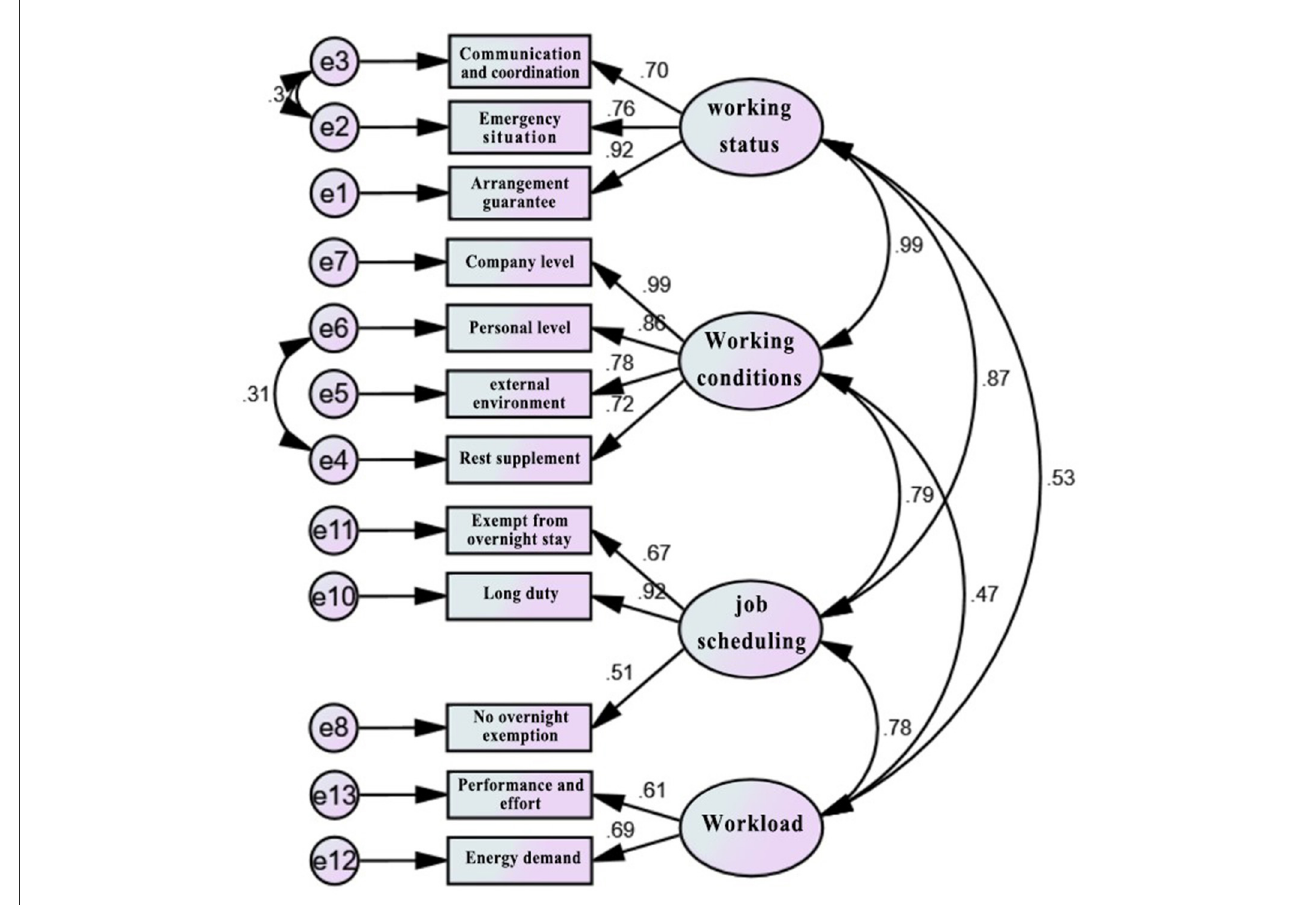
FIGURE4 Path analysis model of fatigue-influencing factors of long-haul flight pilots’ “work”